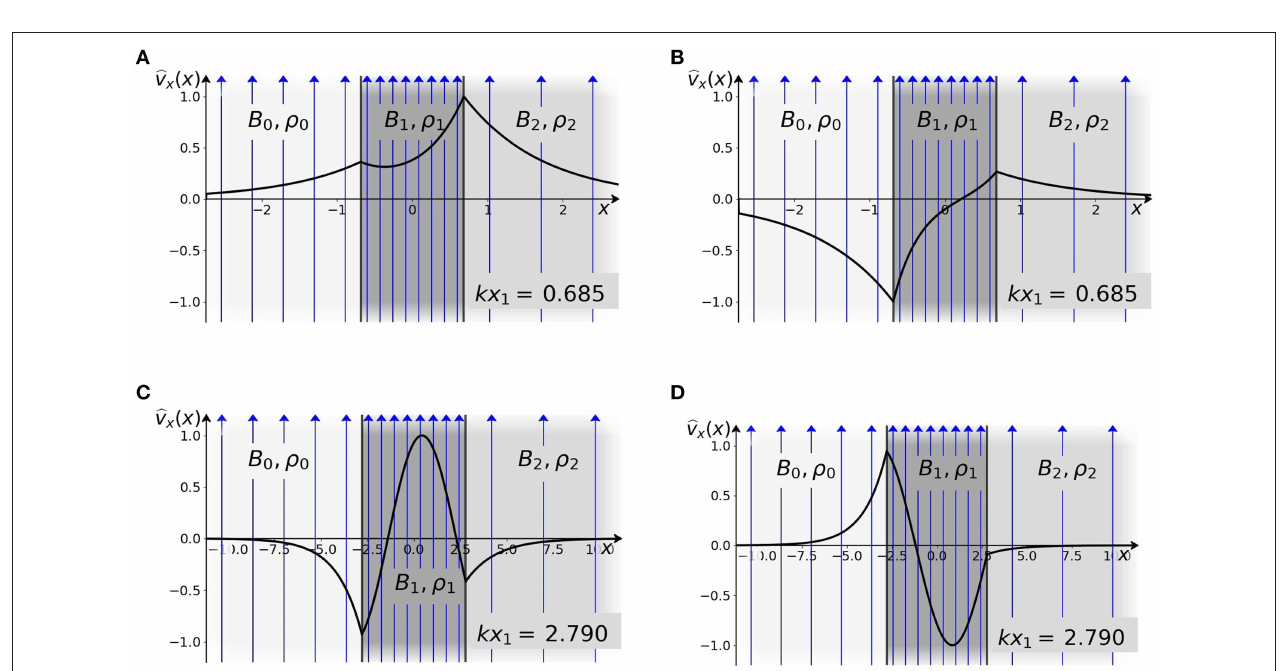
FIGURE 3 | Equilibrium configuration for the magnetic slab in an asymmetric magnetic environment.